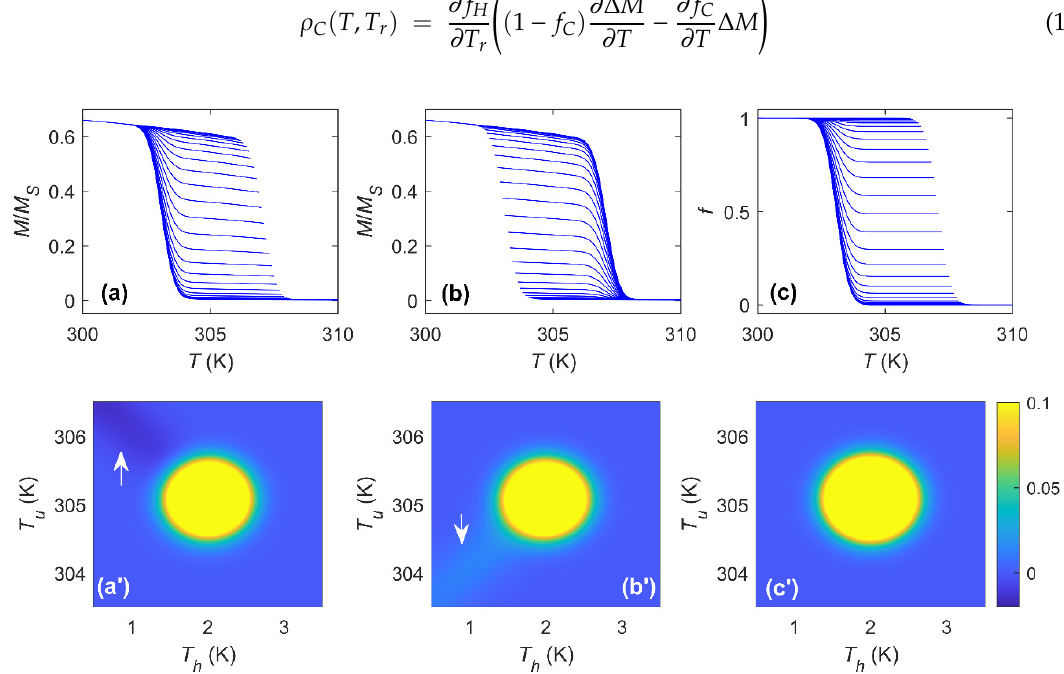
Figure 4. First order reversal magnetization curves and associated TFORC distributions with (cid:2022) (cid:3009) = (cid:1846) (cid:3047),(cid:3020)(cid:3021) + 2 K , (cid:2022) (cid:3004) = (cid:1846) (cid:3047),(cid:3020)(cid:3021) − 2 K , (cid:2026) (cid:3009) = (cid:2026) (cid:3004) = 0.4 K (skewness not considered) for ( a )–( a’ ) cooling and ( b ) – ( b’ ) heating. ( c )–( c’ ) Cooling reversible magnetization curves and TFORC distributions using only the transformed phase fraction.